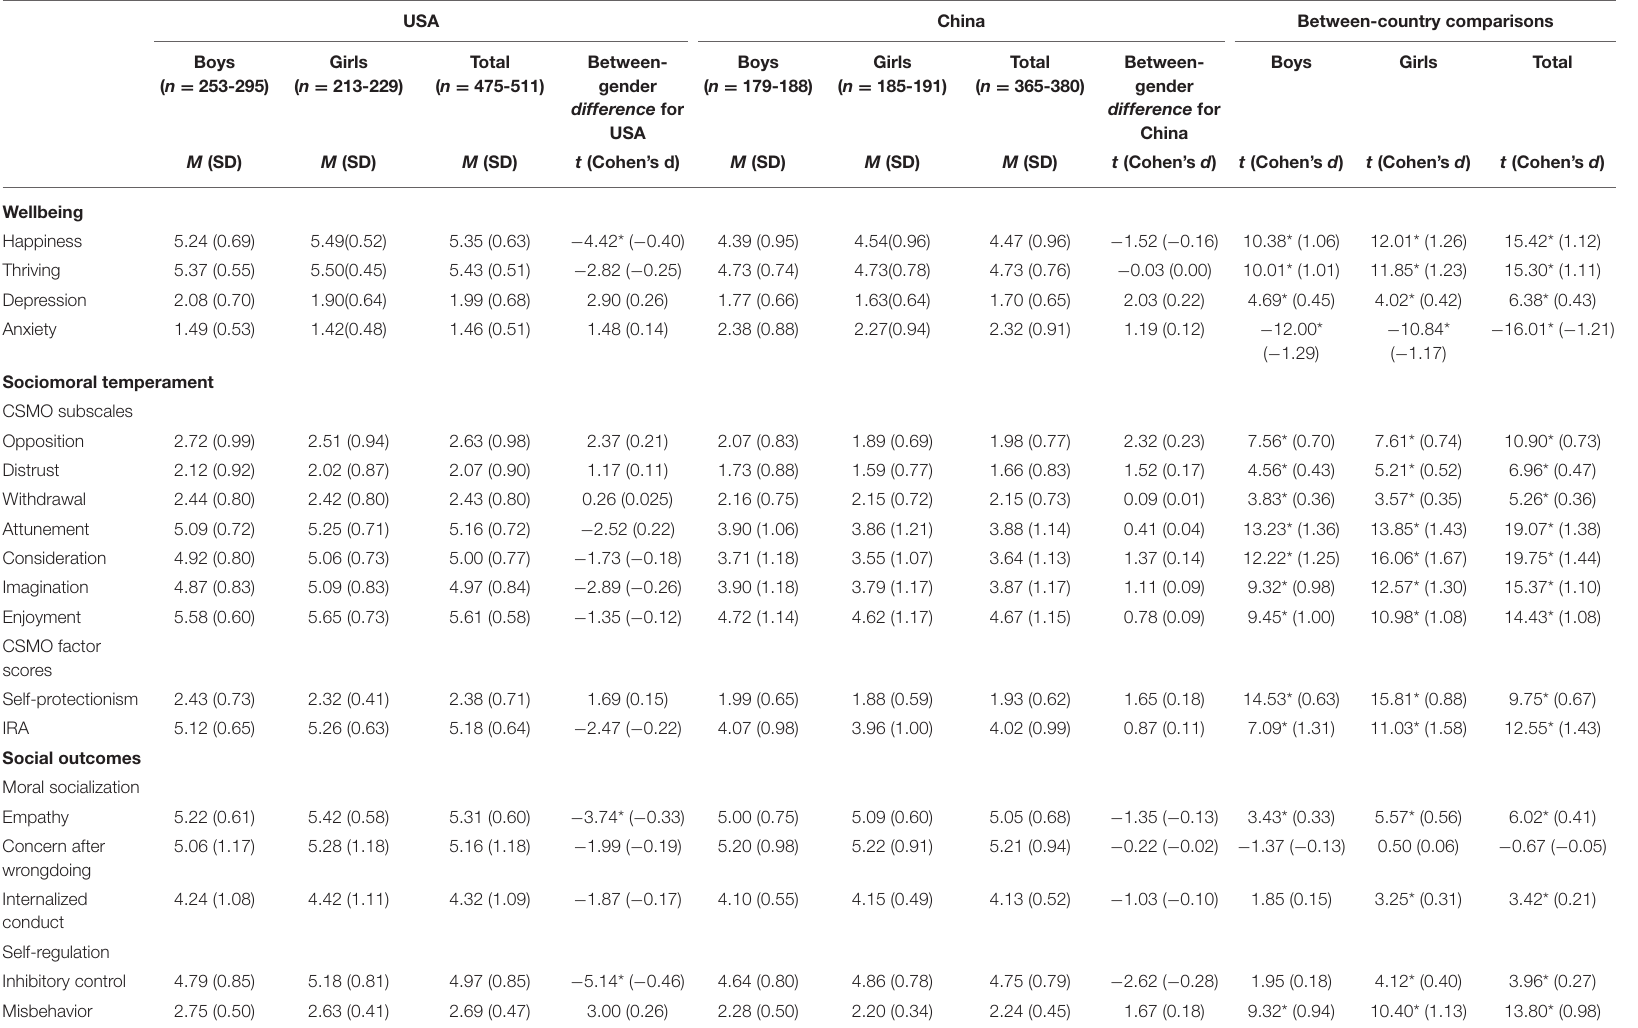
TABLE 2 | Descriptive statistics for Study 1 (USA) and Study 2 (China) by country and gender with between-group